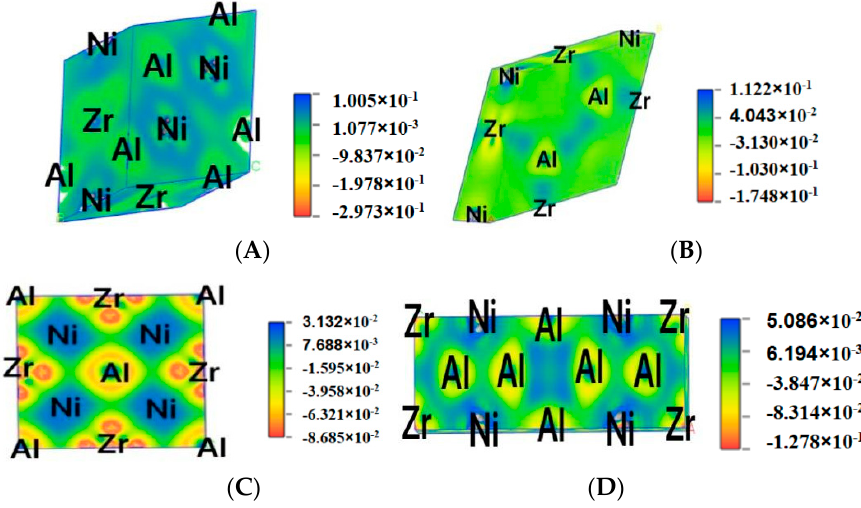
Figure 6. Difference ch arge density maps of Al x Ni y Zr z , ( A ) AlNiZr, ( B ) Al 2 NiZr 6 , ( C ) AlNi 2 Zr, ( D ) Al 5 Ni 2 Zr.